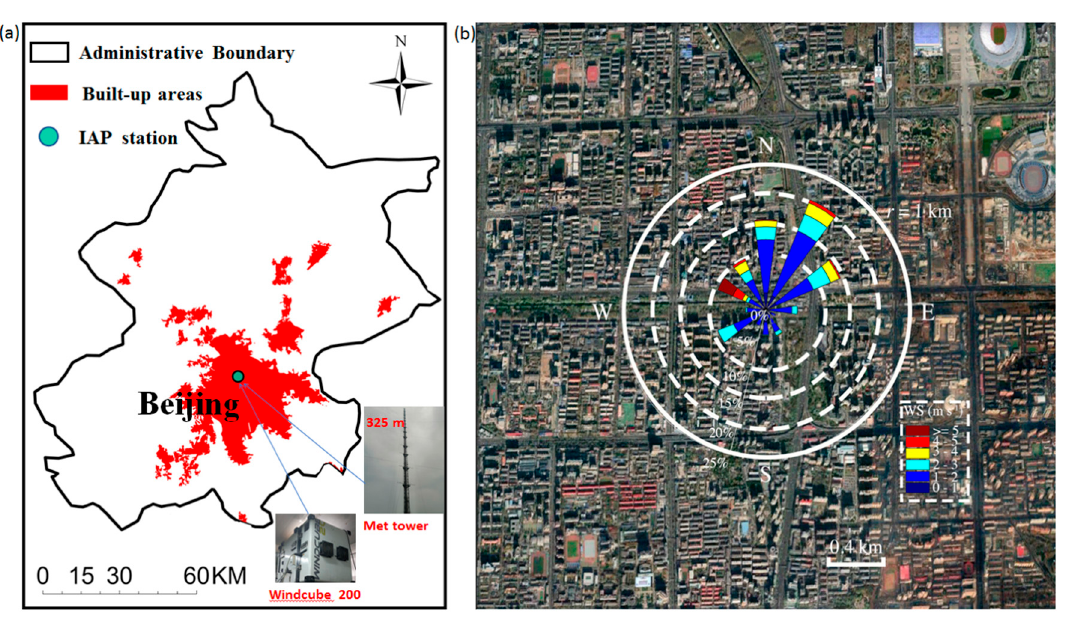
Figure 1. The map of urban Beijing area and location of the 325-meteorological tower and the Doppler wind lidar at the Institute of Atmospheric Physics (IAP) station ( a ), and the aerial photograph of the urban Beijing area around met tower (4 km × 4 km) ( b ). The wind rose shows the results observed in these 31 days.